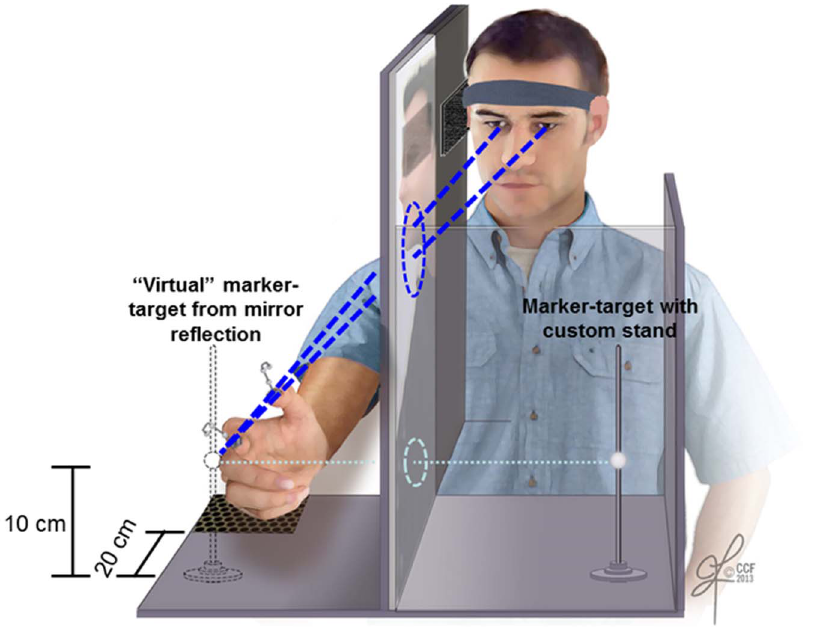
Figure 2. Subject performs reach-to-pinch maneuver towards ‘‘virtual’’ target with no visual feedback of moving hand and grasping digits.